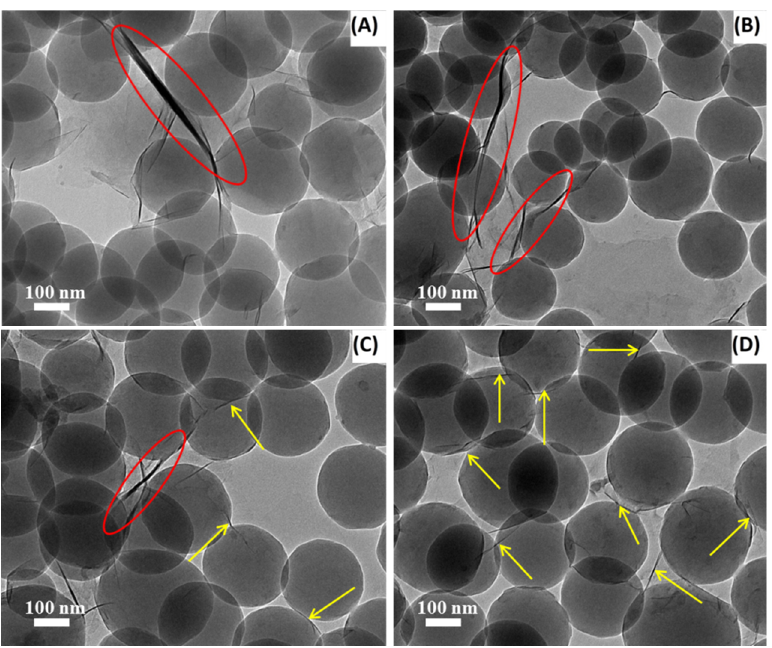
Figure 8. TEM images obtained for ( A ) PS/Si-P-Mt, ( B )PS/P-Si-Mt, ( C ) PS/H-Si-P-Mt and ( D ) PS/H-P-Si-Mt nanocomposites.